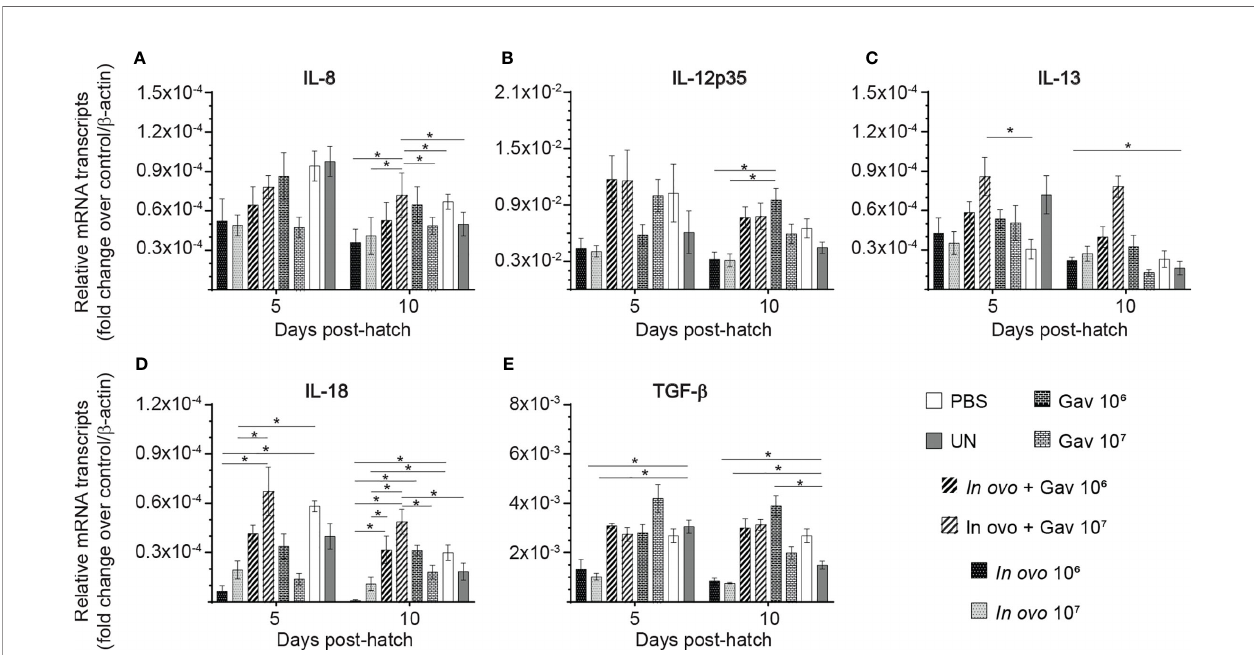
FIGURE 2 | Relative gene expression in the spleen of chickens inoculated with lactobacilli. Spleen samples were collected at days 5 and 10 post-hatch from all treatment groups: groups 1 and 2 received 10 6 and 10 7 CFUs of lactobacilli cocktail in ovo , respectively, at embryonic day eighteen; groups 3 and 4 received 10 6 and 10 7 CFUs of lactobacilli, respectively, via both in ovo and oral gavage (on days 1, 7, 14, 21, 28 post-hatch); groups 5 and 6 received 10 6 and 10 7 CFUs of lactobacilli, respectively, via oral gavage; group 7 was served as a negative control group and was injected with phosphate-buffered saline (PBS); group 8 remained untreated (UN). Fold change was used to characterize differences in gene expression of IL-8, IL-12, IL-13, IL-18 and TGF- b (A – E) , in comparison to negative control group. Statistical signi fi cance among treatment groups was calculated using SAS Proc GLM (General Linear Model) followed by Tukey ’ s comparison test. Error bars represent standard errors of the mean. Results were considered statistically signi fi cant if P < 0.05. Bars with asterisks represent a signi fi cant difference among treatments. The data are representative samples from 6 individual